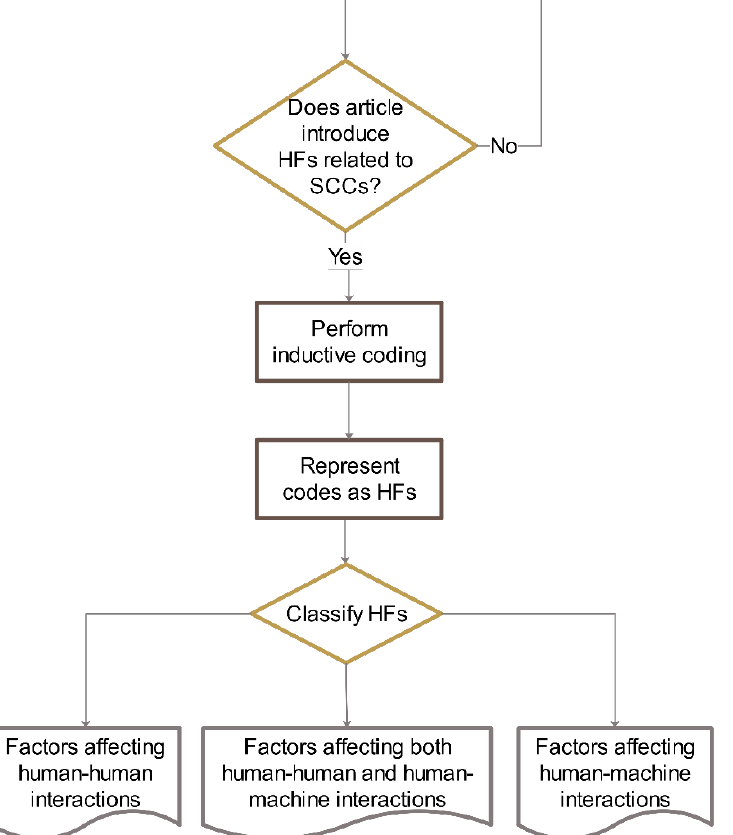
Figure 1. Process flow for identifying human factors (HFs) affecting shore control centers (SCCs) from the literature.